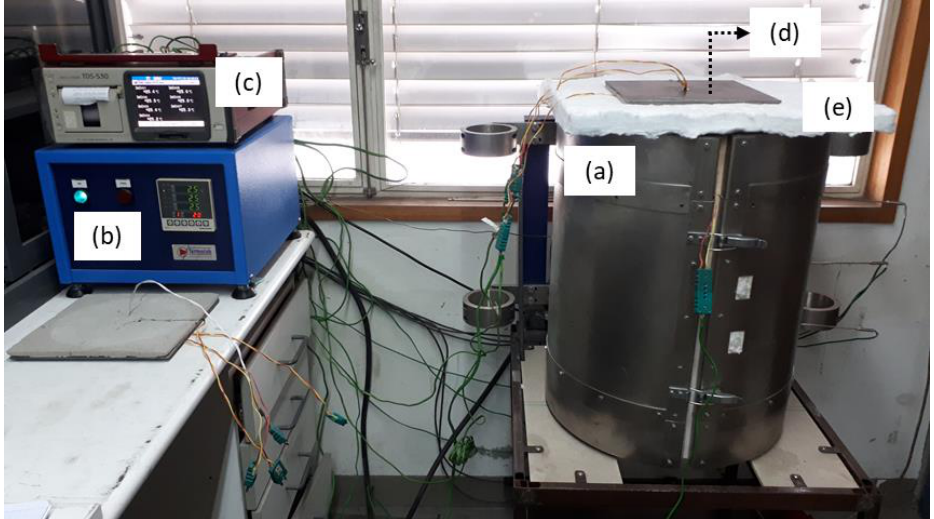
Figure 7. Experimental setup: ( a ) cylindrical oven ( b ) oven controller ( c ) data acquisition system ( d ) specimen ( e ) rock wool.